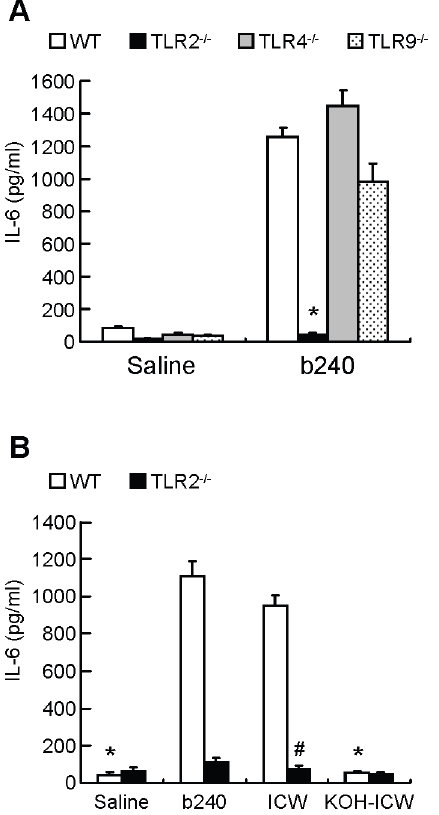
Figure 3. Involvement of TLR signals in the IL-6-inducing ability of b240. (A) PP cells (5.8 6 10 5 cells) from WT (white), TLR2 2 / 2 (black), TLR4 2 / 2 (gray), or TLR9 2 / 2 (dotted) mice were cultured with or without heat-killed b240 (4.7 6 10 6 counts) for 4 days. IL-6 in the culture supernatants was determined by CBA. * P , 0.05 versus WT in b240 group by Dunnett’s test. The saline group was not tested. (B) PP cells (5.8 6 10 5 cells) from WT (white) or TLR2 2 / 2 (black) mice were cultured with or without heat-killed b240 (4.7 6 10 6 counts), the intact cell wall (ICW), or the KOH-treated ICW for 4 days. The ICW and the KOH-treated ICW were applied in the same amount as heat-killed b240. IL-6 in the culture supernatants was determined by CBA. * P , 0.05 versus b240 in the WT group by Dunnett’s test, and the TLR2 2 / 2 group was not tested. # P , 0.05 versus WT in the ICW group by Student’s t -test. Data are expressed as mean 6 SEM (n=3–6). Data are (A) combined or (B) representative of 2 independent experiments.